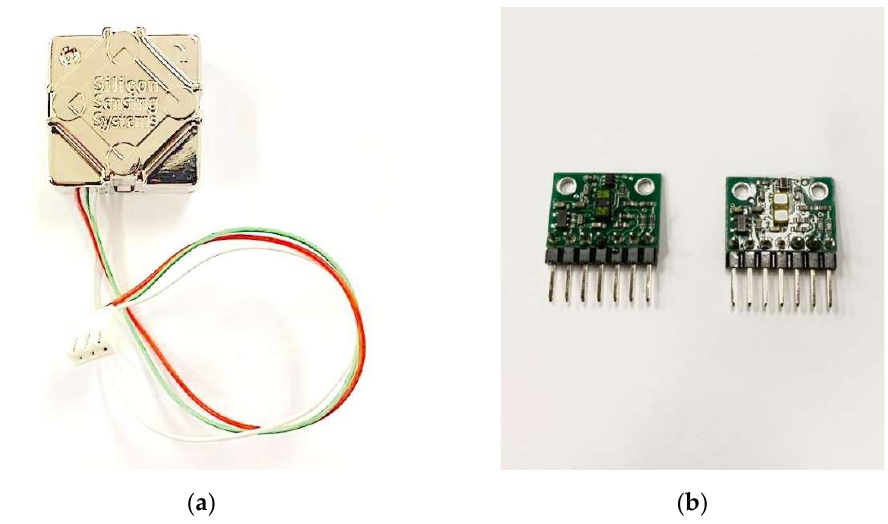
Figure 6. Adapted Sensor. ( a ) Gyro sensor; ( b ) Distance sensor.